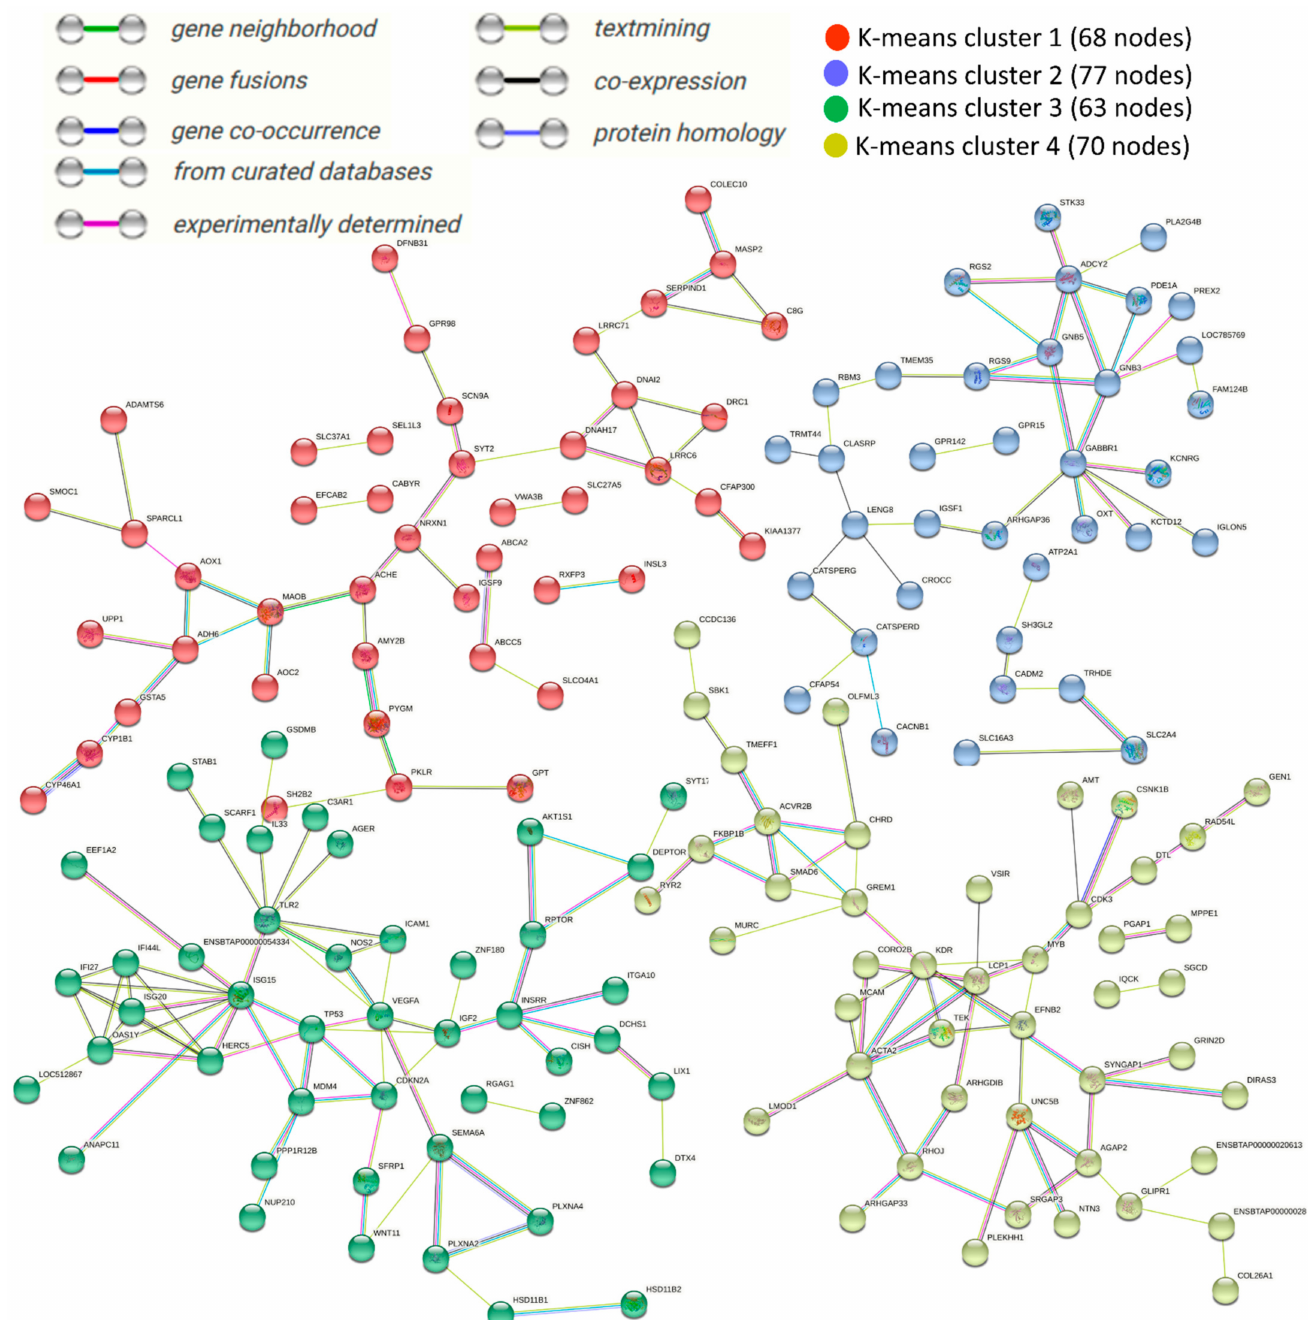
Figure 8. STRING interaction analysis of all differentially expressed genes (DEGs) in control versus heat-stressed granulosa cells. Interaction was performed with confidence score of 0.4. String inter- action map is divided into 4 k-means clusters with distinct sets of DEGs. Nodes represent DEGs (protein coding genes) and lines between nodes refer to edges of various sorts of interactions denoted by different colors and defined through the legends present in the figure; standalone nodes lacking edges were